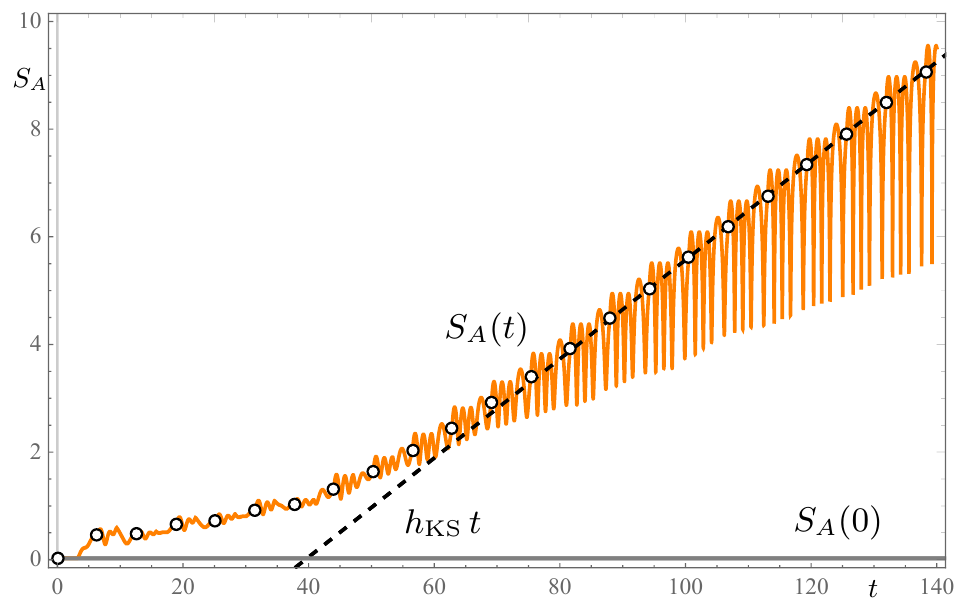
Figure 5 . Periodic quantum quenches in a harmonic lattice . We show the entanglement entropy S A ( t ) as a function of time for the subsystem spanned by ( q 1 ; p 1 ). The stroboscopic entanglement entropy S A ( n 2 T 0 ) is indicated by white dots. The asymptotic prediction of the Kolmogorov-Sinai production rate S A ( t ) (cid:24) h KS t with h KS = 0 : 092 is shown as a dashed line where we adjusted the o(cid:11)set for easy comparison of the slope. Note that the entanglement entropy stays constant in the interval [0 ; T 0 ] as expected from the fact that the system is prepared in the ground state of the initial Hamiltonian H